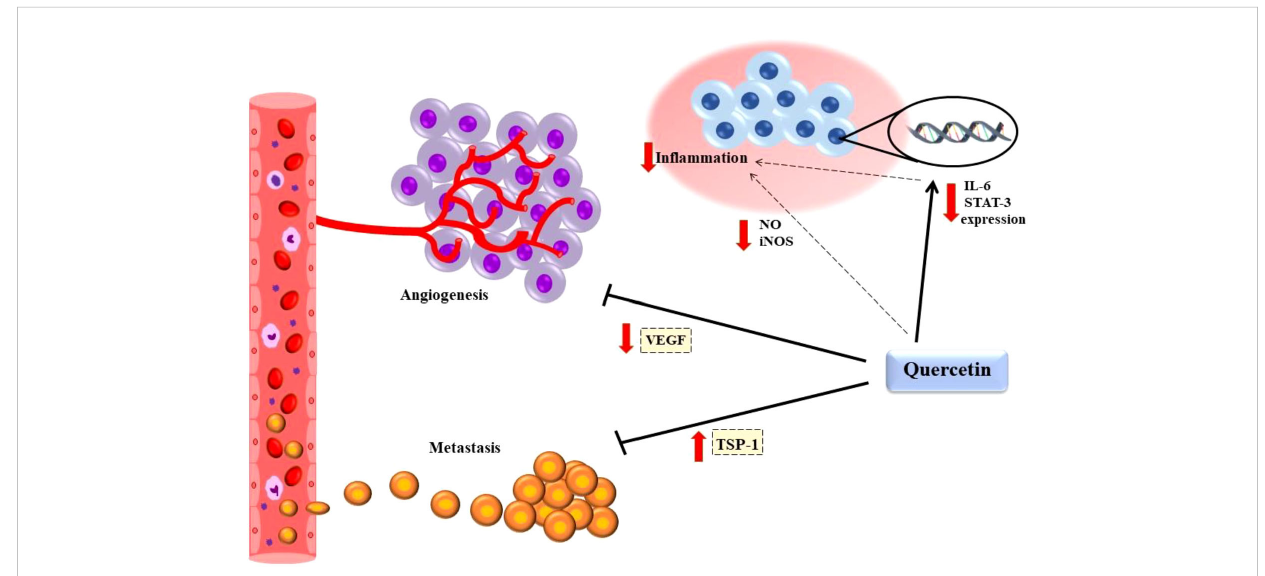
FIGURE 2 Quercetin had anti-tumor and anti-in fl ammatory effects. Quercetin declined in fl ammatory condition through decreasing VGEF-A, NO, iNOS. Also, It increased TSP-1 mRNA and protein expression to prevent angiogenesis and suppressed metastasis by reducing VEGF secretion. Vascular endothelial growth factor A (VEGF-A); Nitric oxide (NO); Inducible nitric oxide synthase (iNOS); Thrombospondin-1